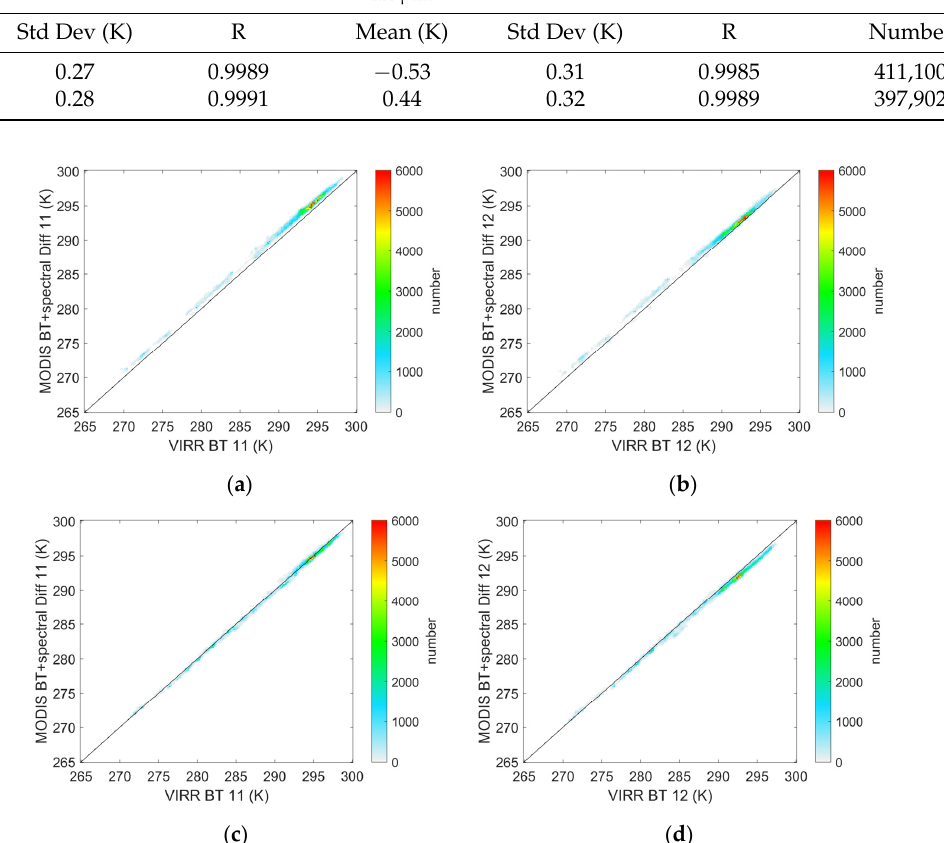
Figure 4. The relationship between MODIS_BT plus the spectral difference and VIRR_BT: ( a ) 11 μ m in the daytime; ( b ) 12 μ m in the daytime; ( c ) 11 μ m in the nighttime; ( d ) 12 μ m in the nighttime. The MODIS_BTs with the spectral difference are used to calibrate the VIRR_BTs using Equations (1) and (2). The fitting coefficients of scale and offset are obtained, respectively, for 11 μ m channel in the daytime, 12 μ m channel in the daytime, 11 μ m channel in the nighttime, and 12 μ m channel in the nighttime.